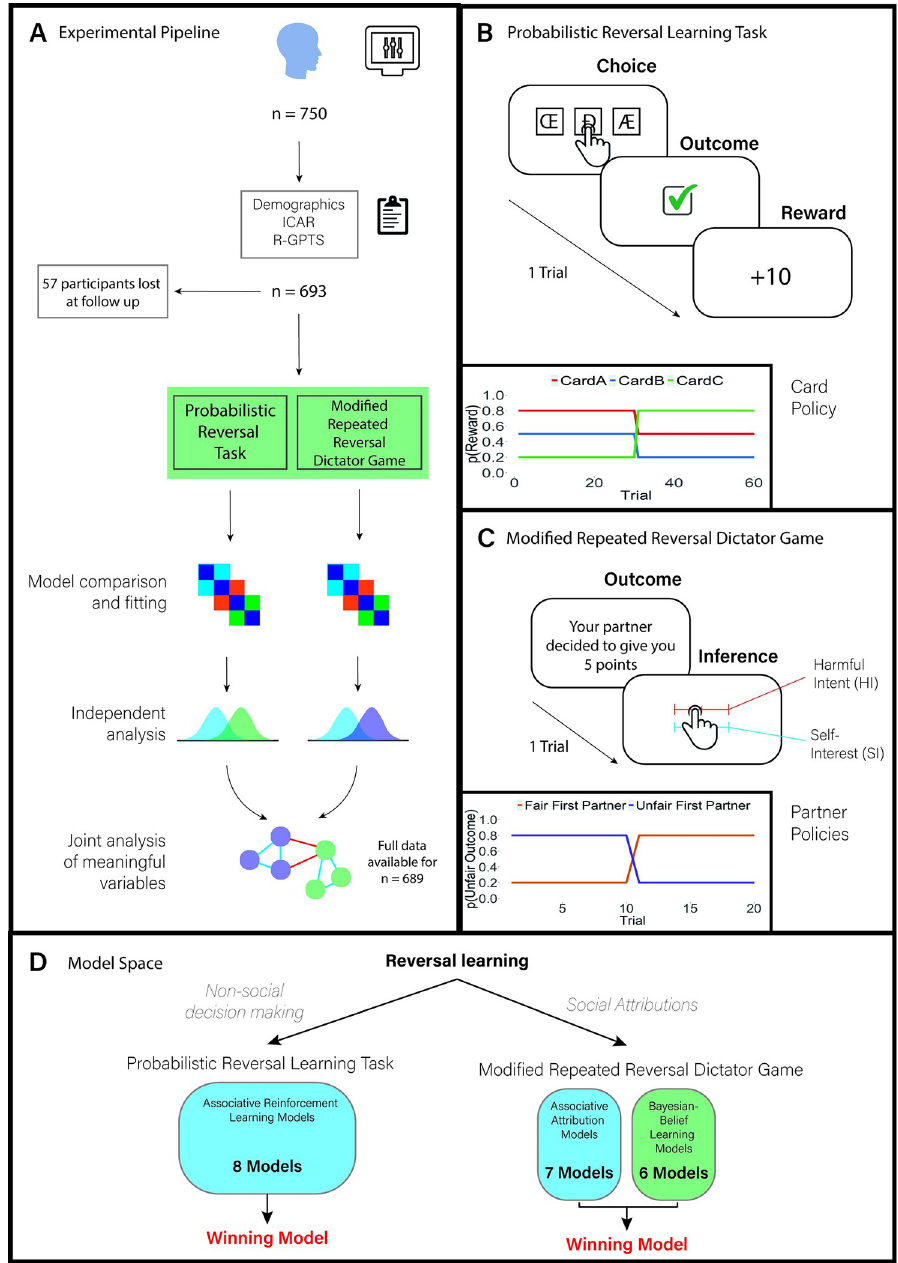
Fig 1. Study design. (A) Experimental design and analysis plan for each paradigm. (B) An example of a trial from the probabilistic reversal paradigm. There were 60 trials in total, and after 30 trials, the contingency of the rewarding card changed unknown to the participant. (C) Example trial from the modified repeated reversal Dictator Game, where participants had to infer their partner’s intent. There were 20 trials in total, and after 10 trials, the contingency of the Dictator changed unknown to the participant. Participants were paired with a partner who was either at first more likely to be fair or unfair, and then changed their policy after the reversal. (D) Model space. Reversal learning was assessed across both non-social decision making and social attributions, using a probabilistic reversal learning task and modified repeated reversal Dictator game as measurement tools, respectively. All models were assessed using MAP estimation with weak priors. The winning models across both Bayesian-belief and associative classes within the repeated reversal Dictator Game were further assessed using Concurrent Bayesian Modelling (Piray et al., 2019).